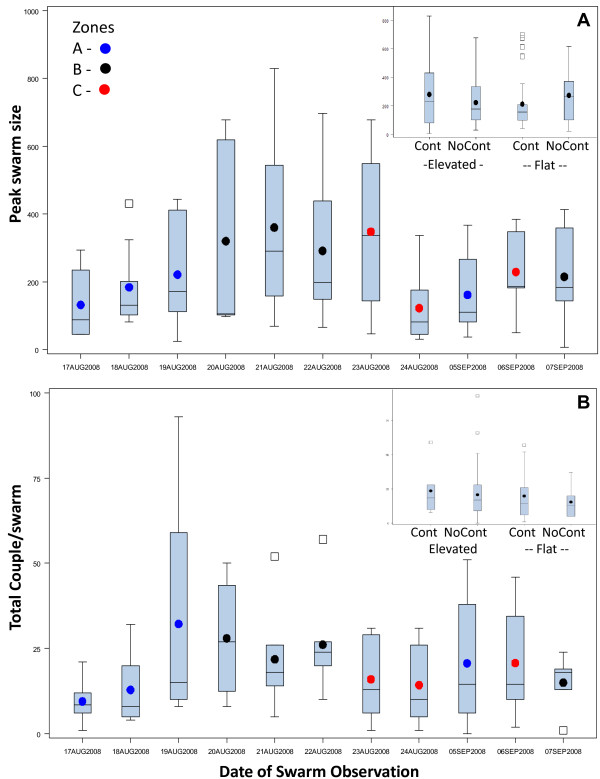
Variation in peak swarm size (A) and the total number of couples per swarm (B) over time in each of the three zones. The box of each box whisker plot extends from the first to the third quartiles (the interquartile range, IQR), the whiskers extend to extreme observations up to 1.5 times the IQR, beyond which observations are marked by squares. The median and the mean are marked by line and a dot. The color of the dot indicates the zone. Sample size per date ranged between 7 and 10 swarms. Insets: Variation in swarm size (A) and the total number of couples per swarm (B) among marker types.